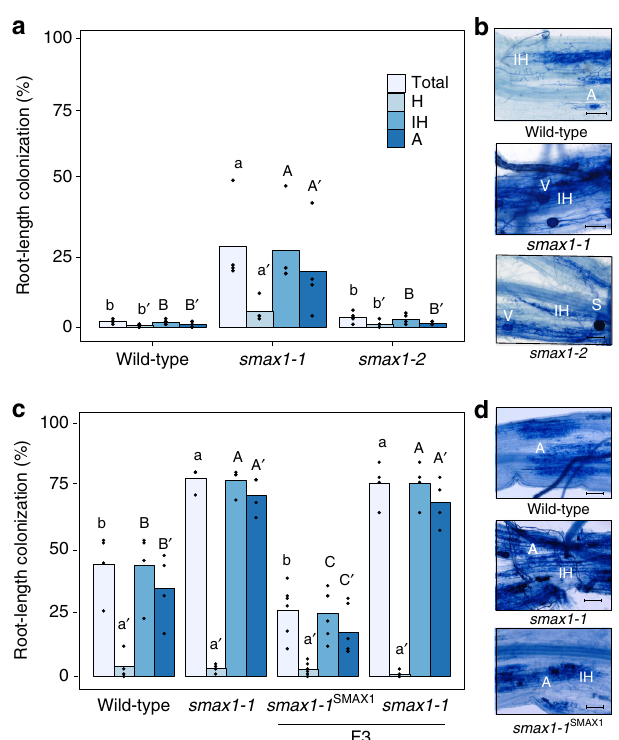
Fig. 1 Root colonisation of smax1 mutant and wild-type by R. irregularis . a AM colonisation levels of two smax1 mutant alleles at 4 weeks post inoculation (wpi) with 300 spores. Each bar indicates the average percentage value of the respective fungal structure. Total, total colonisation, H, hyphopodia, IH, intraradical hyphae, A, arbuscules. Kruskal- Wallis test was performed, followed by post-hoc pairwise comparison using the Agricolae R package. Different letters represent signi fi cant difference ( p -value < 0.05). Degrees of freedom = 2, wild-type ( n = 5), smax1-1 ( n = 4), smax1-2 ( n = 4), Total: χ 2 = 8.60, p = 0.01; H: χ 2 = 8.20, p = 0.02; IH: χ 2 = 8.40, p = 0.02;A: χ 2 = 8.32, p = 0.02. b Micrographs of trypan blue stained roots for fungal structures in wild-type and smax1 mutants at 4 wpi. Images represent roots from at least three independent plants of each genotype. IH intraradical hyphae, A arbuscule, V vesicle, S spore; scale, 100 μ m. c AM colonisation levels of smax1 mutant allele and the complementation line at 7 wpi. Degrees of freedom = 3, wild-type ( n = 4), smax1-1 ( n = 4), smax1-1 SMAX1 (F3, n = 6), smax1-1 (F3, n = 4), Total: χ 2 = 13.7, p = 0.003; H: χ 2 = 3.01, p = 0.39; IH: χ 2 = 13.9, p = 0.003;A: χ 2 = 14.14, p = 0.003. F3 indicates the segregating third generation plants after crossing smax1-1 mutant with wild-type plants expressing the wild-type SMAX1 transgene. d Micrographs of trypan blue stained roots for fungal structures in wild-type, smax1 and complementation line at 7 the symbiosis marker Phosphate Transporter (PT) 11 39 mRNA in